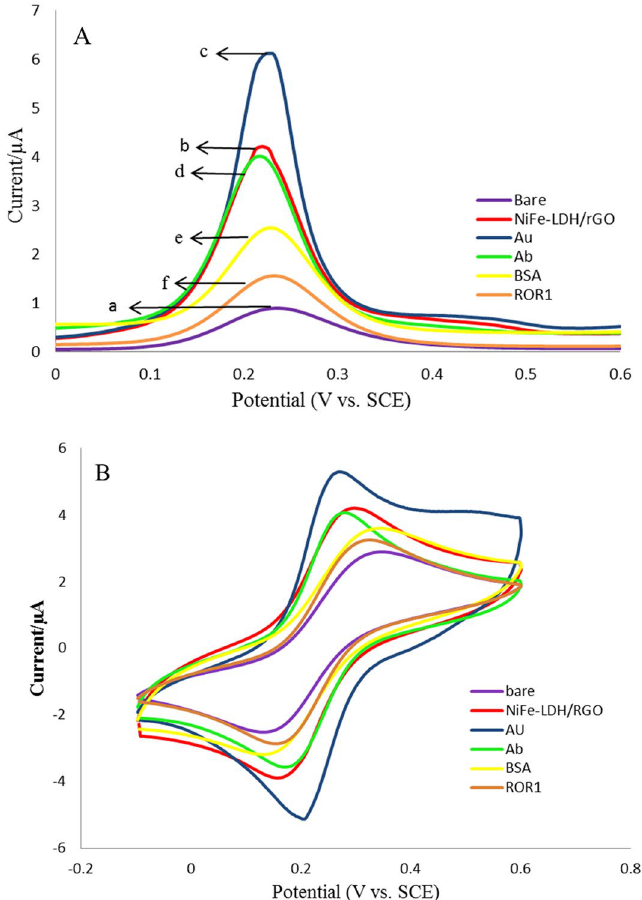
Figure 1. ( A ) The differential pulse voltammetry (DPV) of immobilization steps of the modified electrode in Fe(CN)63−/4−. Scan rate, 100 mV/s; (a) bare GCE, (b) NiFe-LDH/rGO, (c) NiFe-LDH/rGO/AuNPs, (d) NiFe- LDH/rGO/AuNPs/ROR1sAb, (e) NiFe-LDH/rGO/AuNPs/ROR1sAb/BSA, and (f) NiFe-LDH/rGO/AuNPs/ ROR1sAb/BSA/ROR1sAg. ( B ) The cyclic voltammetry (CV) of immobilization steps of the modified electrode in Fe(CN)63−/4−. Scan rate, 100